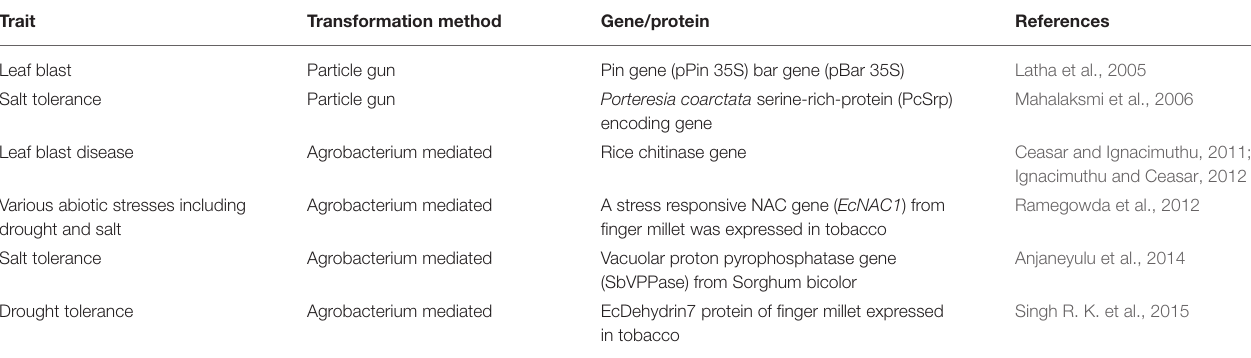
TABLE 4 | Transgenic development efforts in finger millet for stress